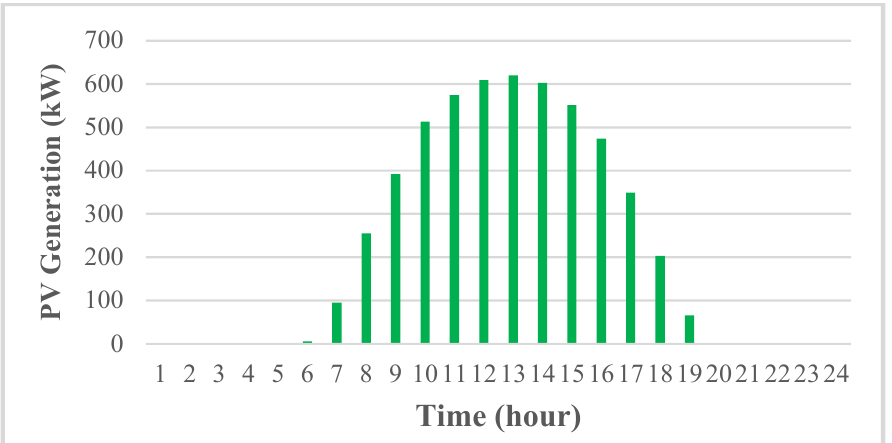
Figure 9. The daily PV generation.